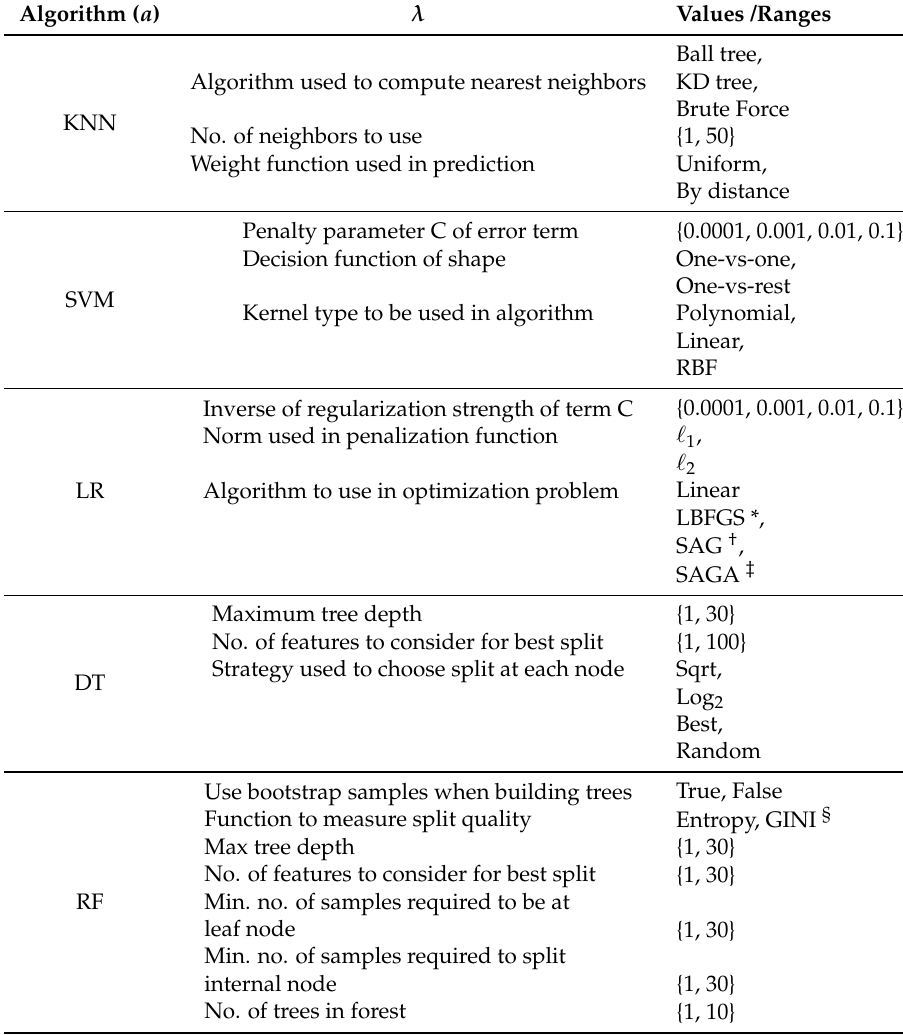
Table 5. Algorithms with their inherent hyperparameters and